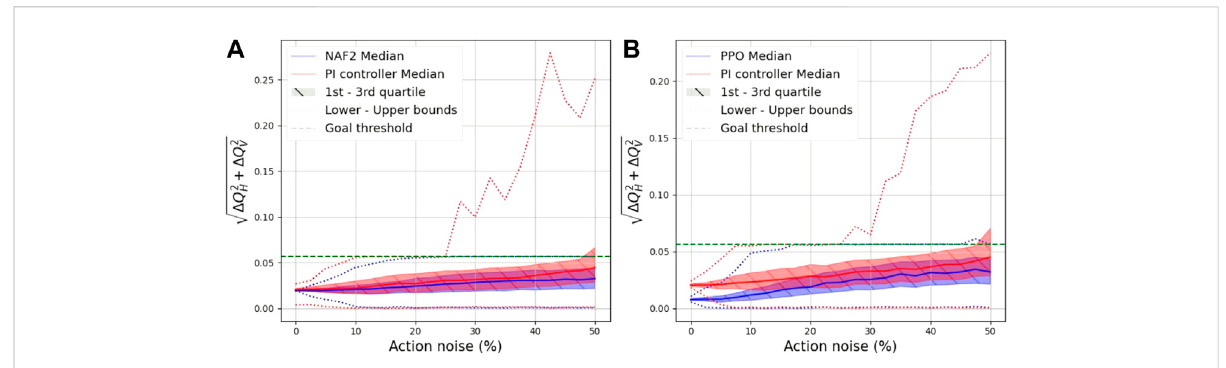
FIGURE 7 Effect of action noise on the distance to the optimal point at the end of the episode due to varying action noise on (A) the best NAF2 agent, (A) the best PPO agent and the PI controller.